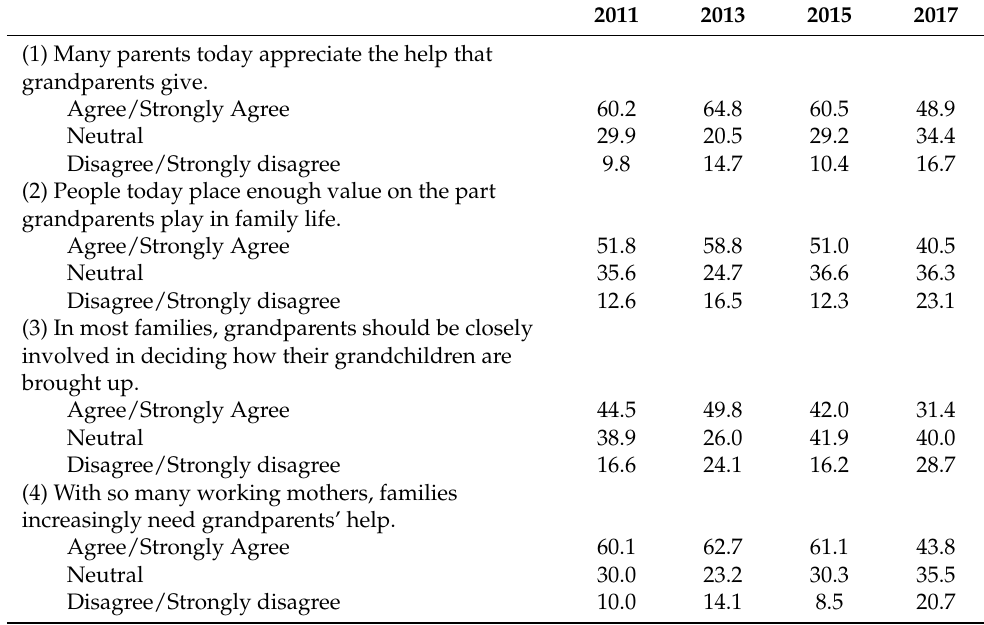
Table 2. Attitudes toward the Involvement of Grandparents in Family Issues